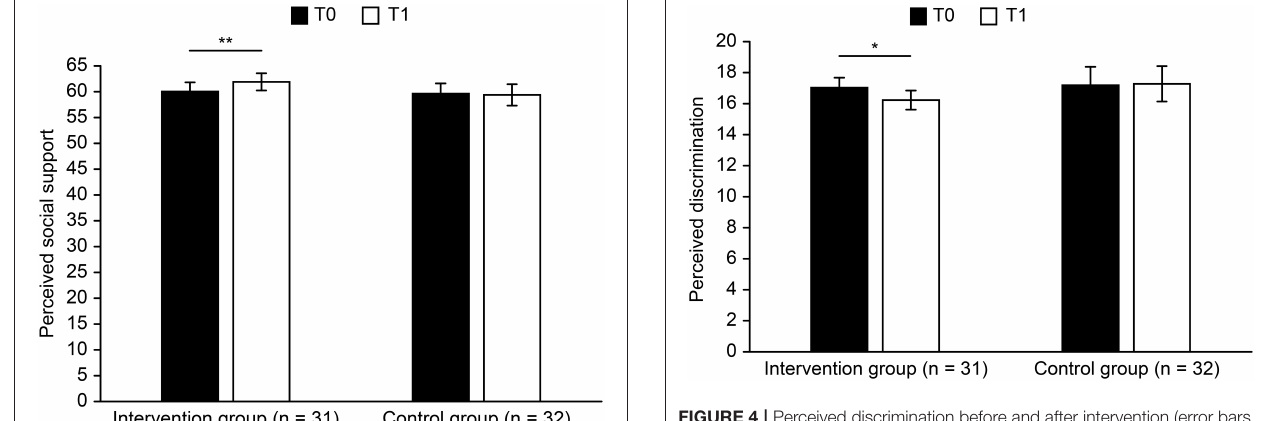
FIGURE 4 | Perceived discrimination before and after intervention (error bars show ± 1 SEM, * p < 0.05). FIGURE 3 | Perceived social support before and after intervention (error bars show ± 1 SEM, ** p < 0.01). = 0.030] main effect of time [ F (1,61) = 1.865, p = 0.177, η 2 p was not significant. No main effect of group [ F (1,61) = 0.213, (ANOVA, Greenhouse–Geisser corrections with corrected = 0.003] was revealed. The interaction between p = 0.646, η 2 p degrees of freedom), with time (T0 vs. T1) as a within-subject = 0.047] was time and group [ F (1,61) = 2.976, p = 0.090, η 2 p factor, and group (Intervention group vs. Control group) as a marginally significant. For the intervention group, the perceived between-subjects factor. Then, independent t -tests and paired discrimination of the participants at T1 was lower than that of t -tests were performed, and perceived discrimination and T0 ( Figure 4 ), t (30) = 2.73, p = 0.010, Cohen’s d = 0.99, while perceived social support were compared with respect to group there were no differences for the control group, t (31) = − 0.22, and time. The effect size estimates η 2 or Cohen’s d were reported. p = 0.828, Cohen’s d = − p